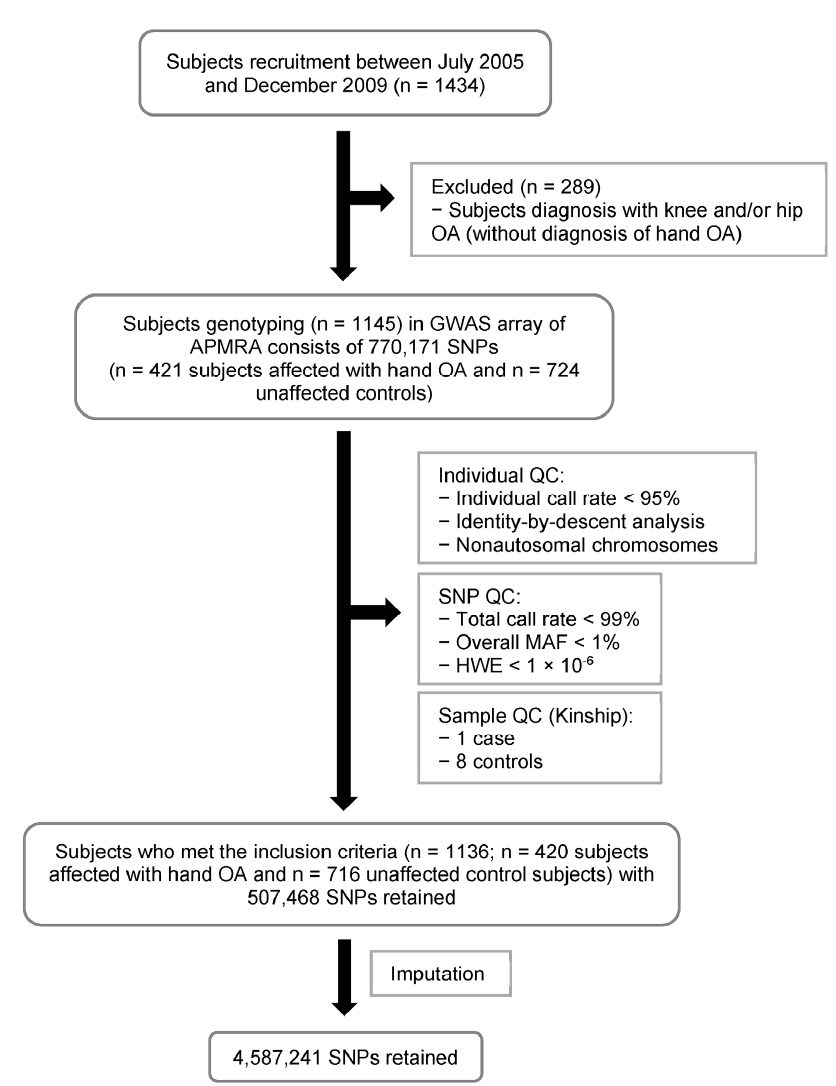
Figure 1. Flowchart of the GWAS hand OA study performed in the Han Chinese population residing in Taiwan.